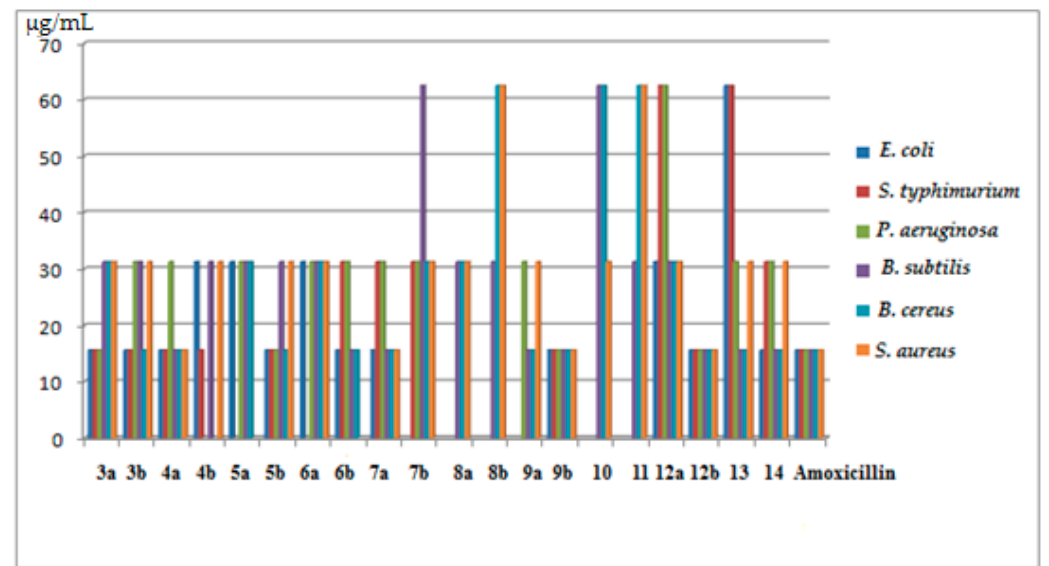
Figure 1. Comparison of antibacterial activity (MIC in µg/mL) of compounds 3a,b–14 and reference antibiotic (amoxicillin trihydrate).